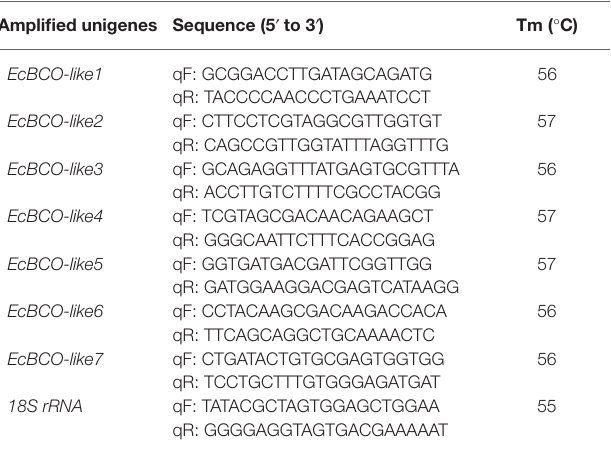
TABLE 1 | Information of primers used for quantitative real-time PCR (qPCR). Amplified unigenes Sequence (5 ʹ to 3 ʹ )